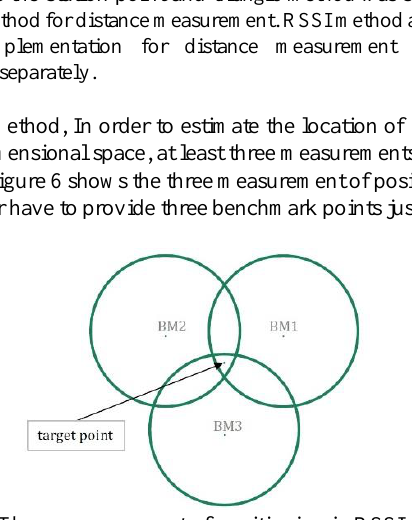
Figure 6. Three measurement of positioning in RSSI